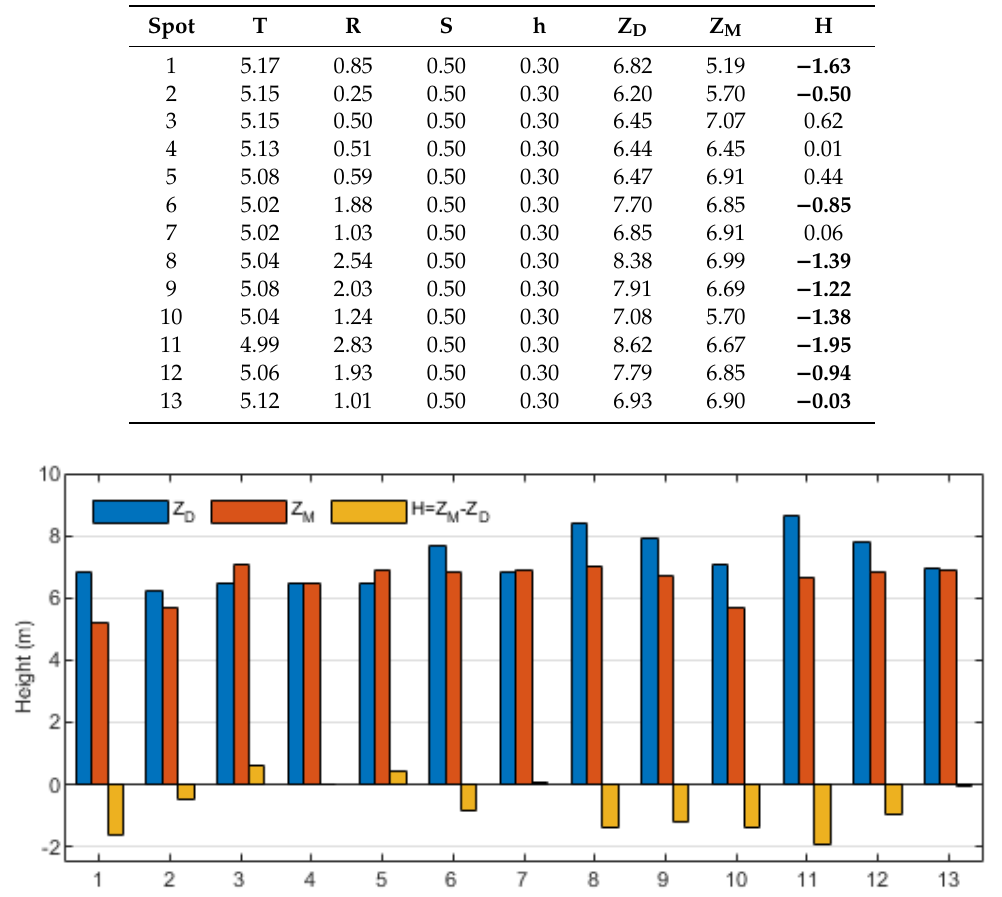
Table 6. Values of designed tidal level for the 100-year period (T), designed wave run-up for the 50-year period (R), security heightened value (S), predicted sea level rise in 2110 (H), designed levee height (Z D ), measured levee height (Z M ), and their di ff erence (H) (unit: m). H in bold indicates Z M is lower than Z D .